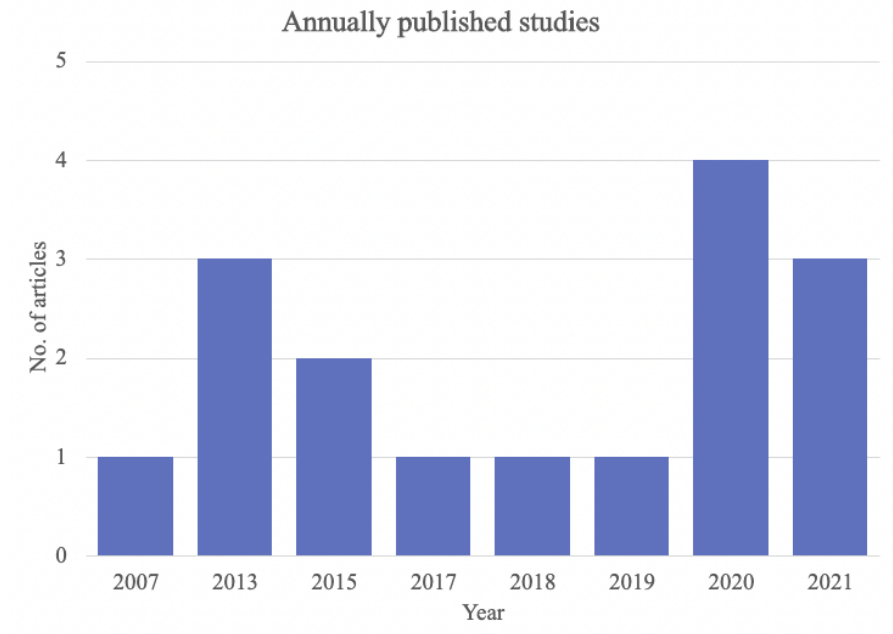
Figure 3. Average number of SRPM studies.